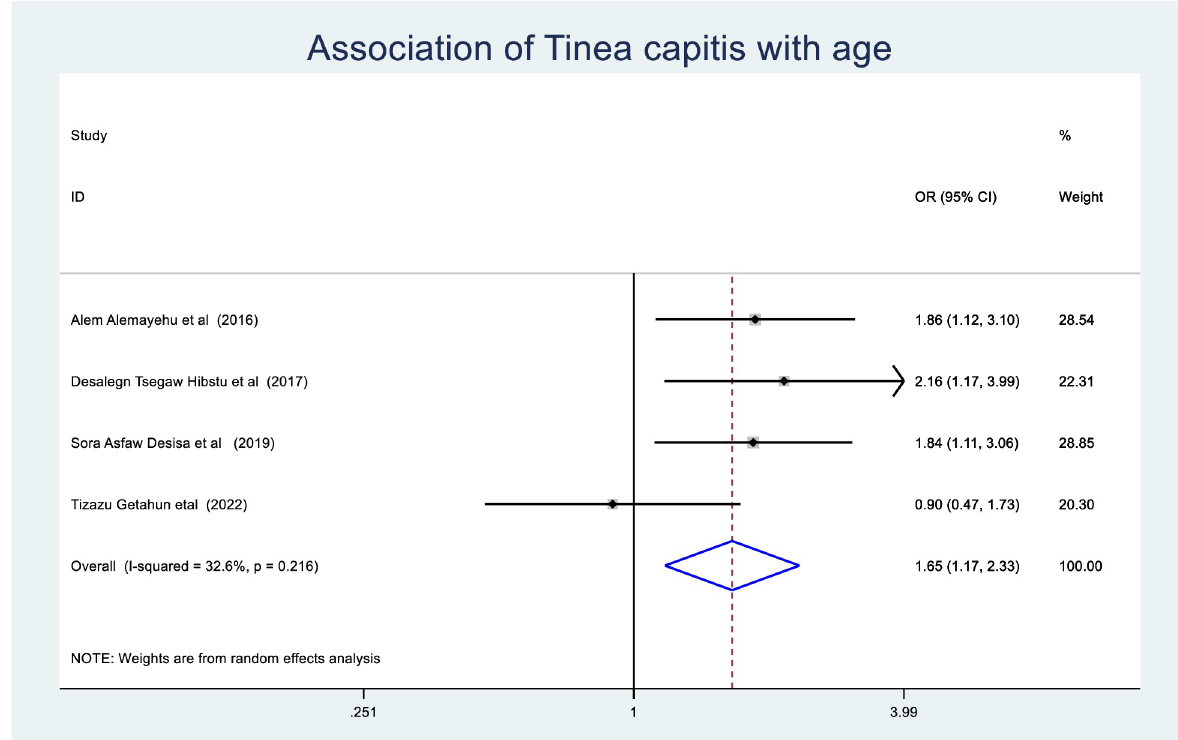
Fig 9. Association of tinea capitis with hair washing experience of